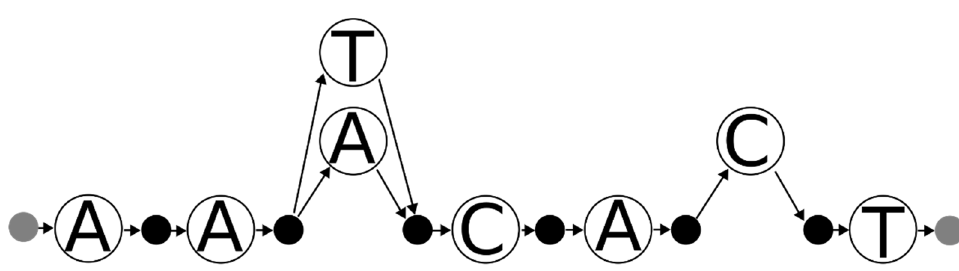
Figure 6. The graph from Figure 5 with three alleles added to it (3T, 3A, and 6C). Note that one of the bases (3T) is the reference sequence. Any variation at a base will delete the reference base. node following the base (see Figure